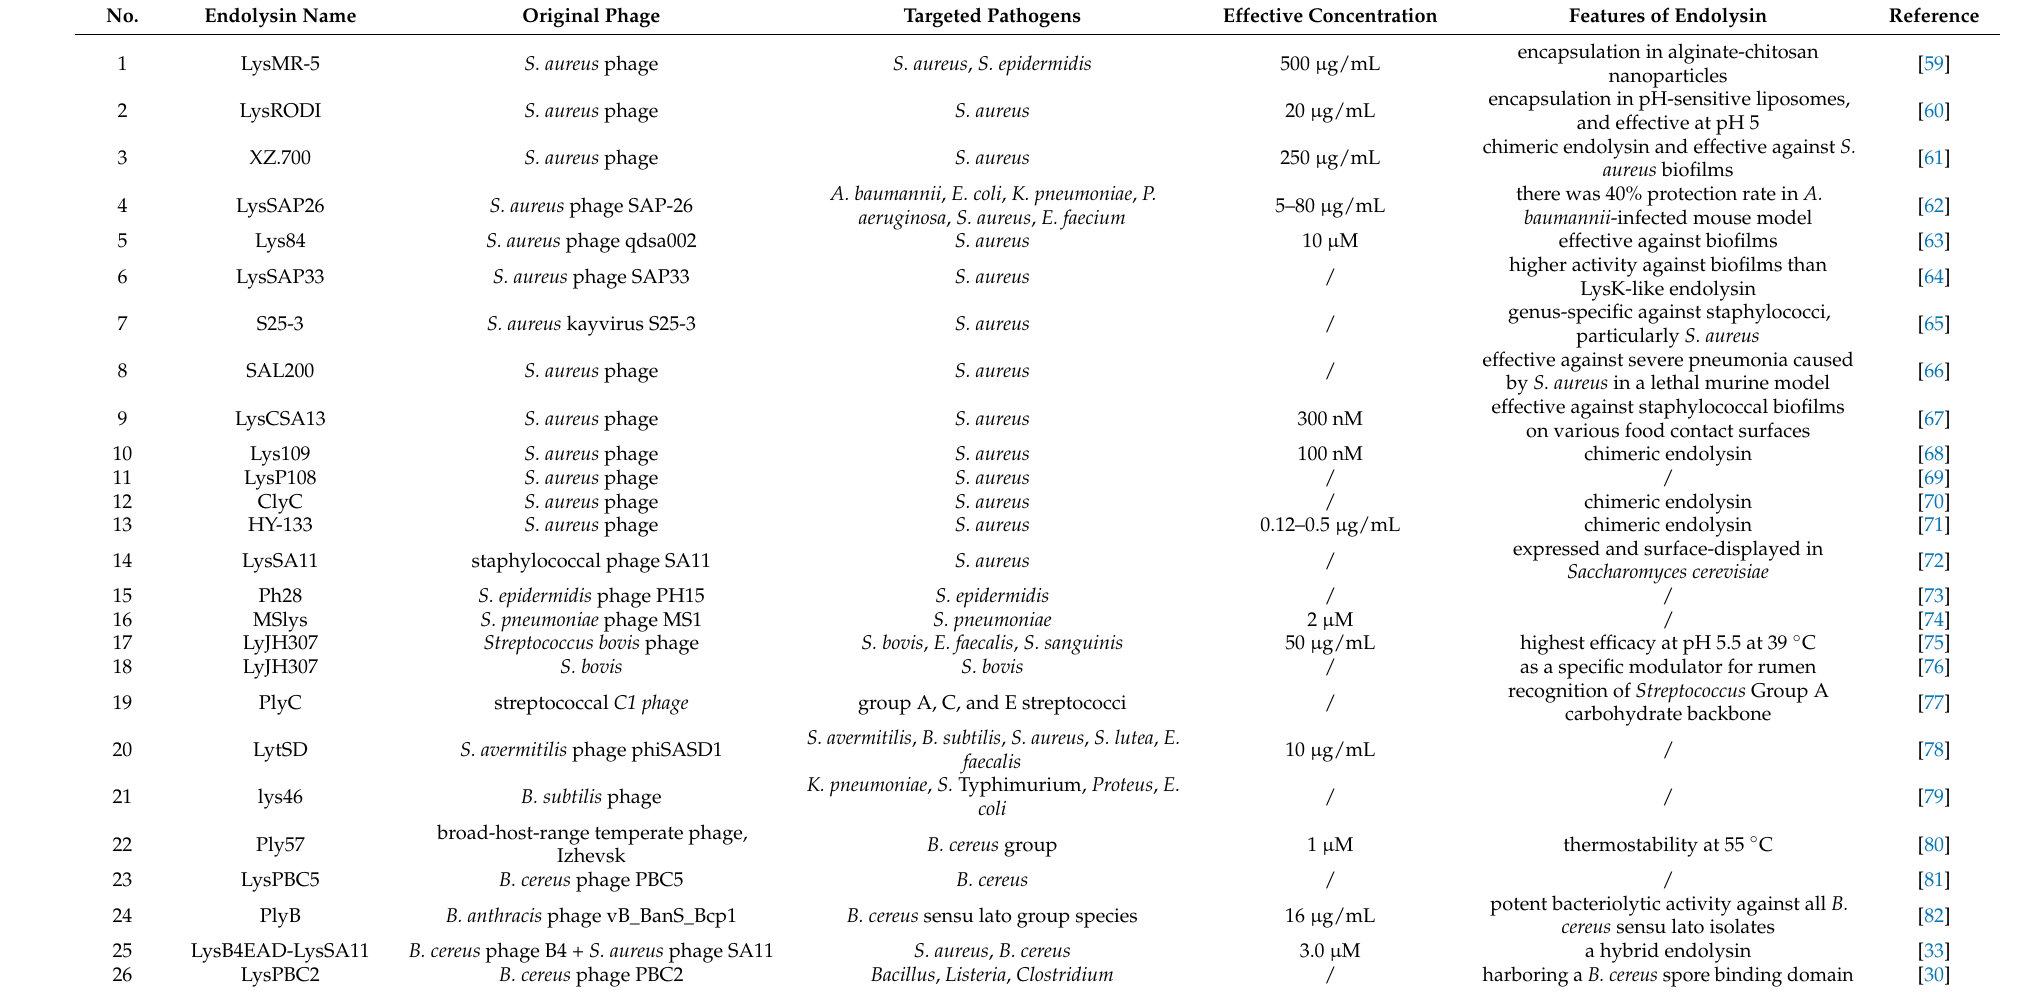
Table 1. Bacteriophage endolysins of Gram-positive bacteria since